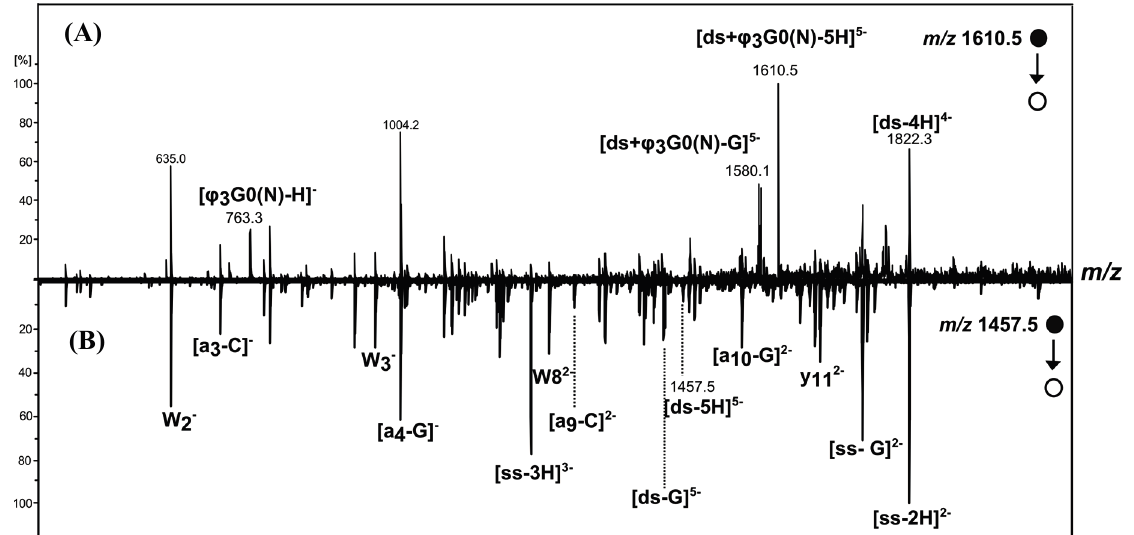
Figure 7. Negative-ion ESI-MS/MS spectra of [ds/ φ 3 G0(N)-5H] 5 − ( m/z 1610.5) ( A ) and [ds-5H] 5 − ( m/z 1,457.5) ( B